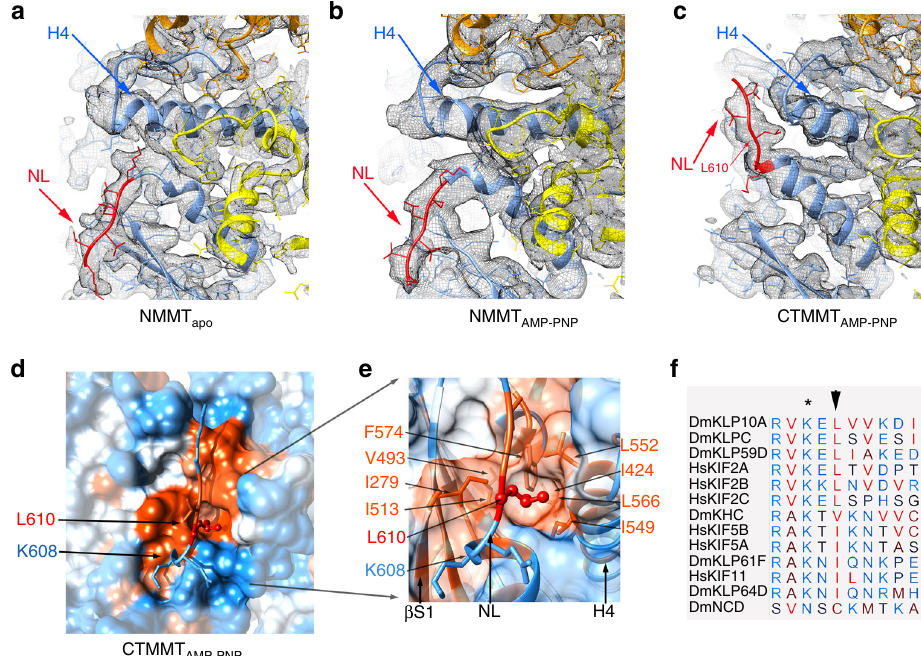
Fig. 6 KLP10A neck-linker docking. The fi gure shows the structure of the beginning of the neck-linker domain present in the KLP10A protein constructs (six residues at the C-terminal end of the motor domain). a NMMT apo . b NMMT AMP-PNP . c CTMMT AMP-PNP Neck-linker in red, KLP10A motor domain in blue, β -tubulin in orange, α -tubulin in yellow, corresponding cryo-EM map density as a gray mesh. d CTMMT AMP-PNP . structure with neck-linker in the up docked position. Core motor domain solvent exclusion surface colored by hydrophobicity with neck-linker shown as ribbon and atom sticks (Kyte and Doolittle hydrophobicity scale with orange to blue representing more to less hydrophobicity). Residue L610 colored red and shown as a ball and stick atom representation. e Close up of the image d showing the KLP10A residues forming the hydrophobic pocket where residue L610 plugs into. Residue K608 marks the end of α -helix 6 and the beginning of the neck linker. f Aligned neck linker sequences of six kinesins-13s (DmKLP10A, DmKLP59C, DmKLP59D, HsKIF2A, HsKIF2B, and HSKIF2C) and seven motile kinesins (DmKHC, HsKIF5B, HsKIF5A, DmKLP61F, HsKIF11, DmKLP64D, and DmNCD). Dm Drosophila melanogaster , Hs Homo sapiens. Asterisk is aligned with DmKLP10A K608. Arrow is aligned with DmKLP10A L610. Structures oriented in a – e with the tubulin plus-end at the top. H4 α -helix 4, NL Neck-linker, β S1 β -strand